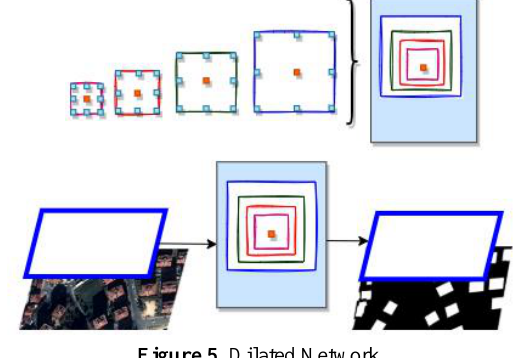
Figure 5 . Dilated